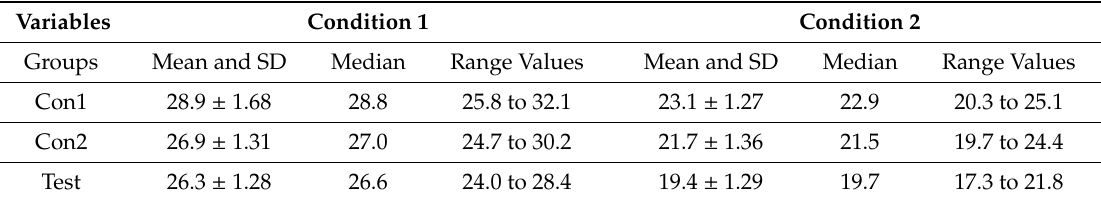
Table 1. Mean, standard deviation (SD), median and range values of the maximum temperature measured for each group in the 2 conditions proposed. Values in centigrade degrees ( ◦